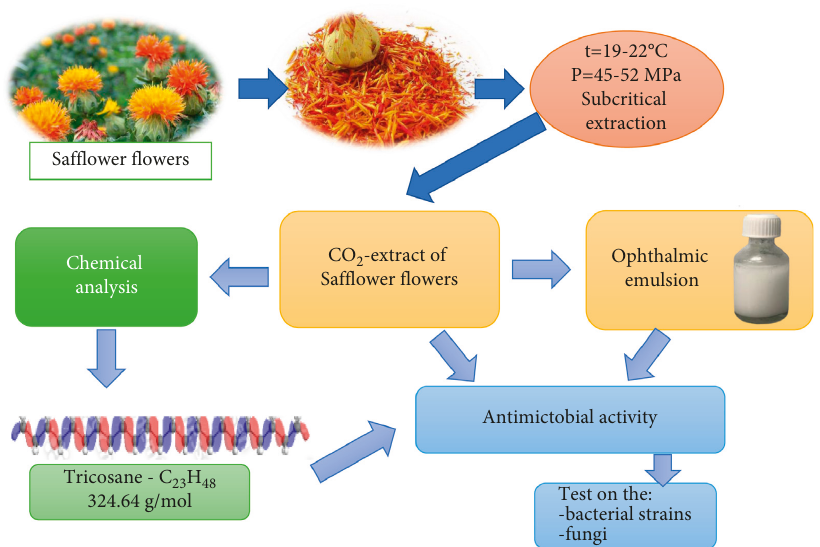
Figure 2: Safflower flowers, ophthalmic emulsion, and their possible antimicrobial